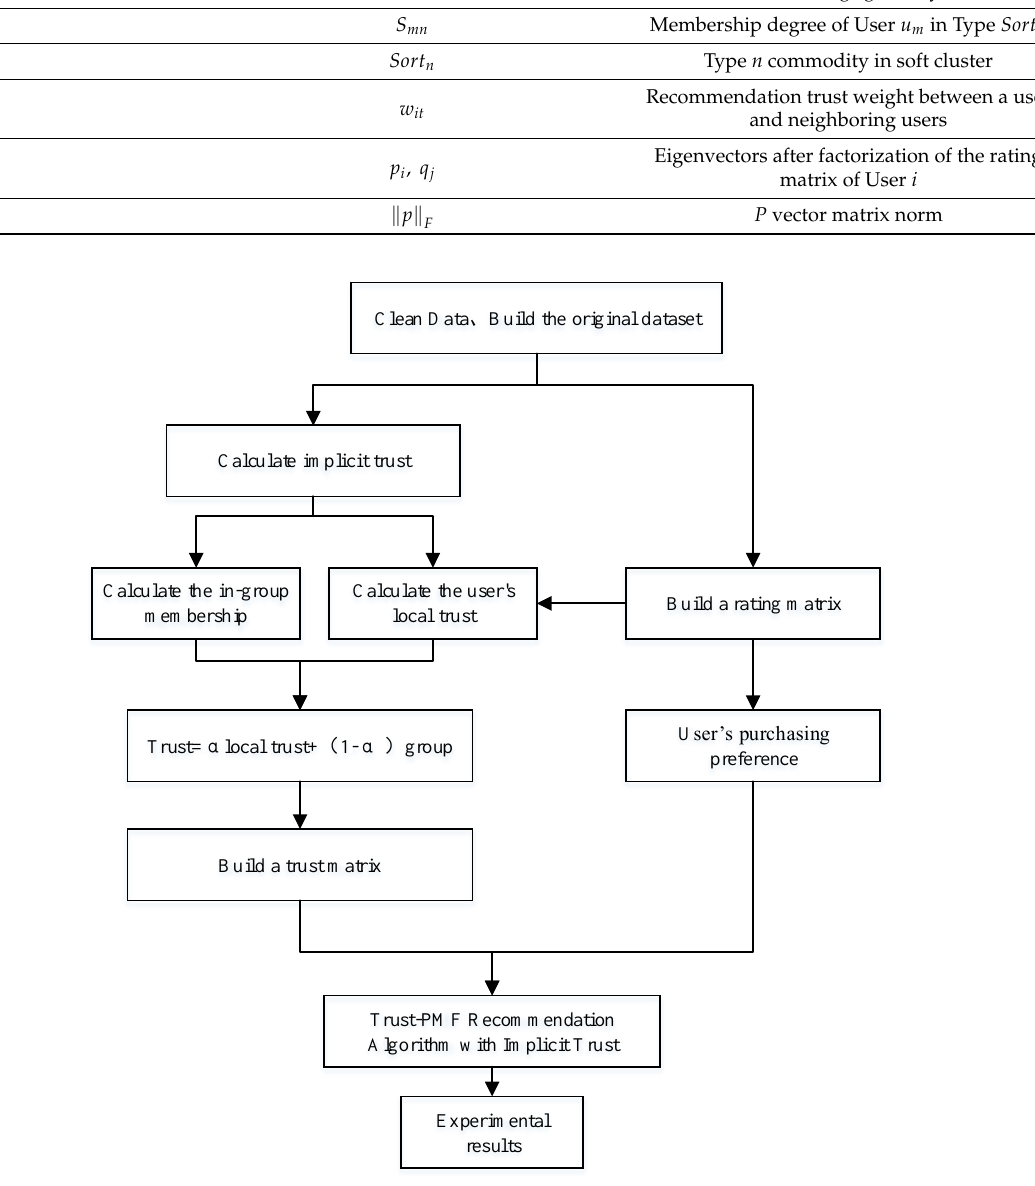
Figure 1. Flow chart of the algorithm.